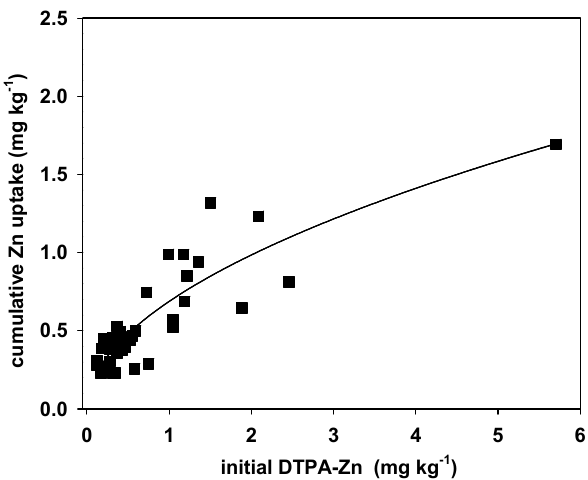
Figure 1. Cumulative Zn uptake by the four crops (expressed in mg kg –1 of soil) as a function of the initial DTPA extractable Zn (mg kg –1 ) in soils. Y = 0.01 + 0.7 X 0.5 ; R 2 = 0.75; p < 0.0001. The rela- tionship is also significant for logarithmic transformation of both variables to meet normality crite- ria. Ln Y = 0.33+ 0.28 Ln X; R 2 = 0.69; p < 0.0001. Cumulative Zn uptake increased with increased initial Olsen P (Y = 0.29 + 0.02 X; R 2 = 0.28; p < 0.001) and with increased Fe ca to Fe cbd ratio (Y = 0.17 + 2.3 X; R 2 = 0.29; p < 0.001) in soils. In addition, the ratio of the cumulative P uptake to Zn uptake also increased with increased Olsen P in soils (Y = 19.9 + 0.43 X; R 2 = 0.26; p < 0.01). The decrease in DTPA-Zn after 4 crops was on average 0.24 mg Zn kg –1 , ranging from –0.2 to 1.8 mg kg –1 . Negative values mean that Zn fertilization covered Zn uptake by crop and even increased the value of the Zn availability index in soil. The decrease in DTPA- Zn after four crops increased with increased Zn uptake by crops (Figure 2a) and with increased initial DTPA-Zn (Figure 2b). In soils with initial DTPA-Zn below the assumed threshold value for Zn deficiency (DTPA-Zn = 0.5 mg kg –1 ), the decrease in DTPA-Zn was less than 0.2 mg kg –1 (Figure 2b), and in some cases, this decrease was negative. For these soils, the decrease in DTPA-Zn after four crops was on average 0.02 mg kg –1 , and the mean cumulative Zn uptake by crops was 0.36 mg kg –1 , equivalent to 57% of applied Zn ferti- lizer. In soils above the threshold value, the decrease in DTPA-Zn after four crops was on average 0.46 mg kg –1 , and the cumulative Zn uptake by crops was 0.77 mg kg –1 . D ec r ease i n D T P A Zn ( m g k g - 1 )